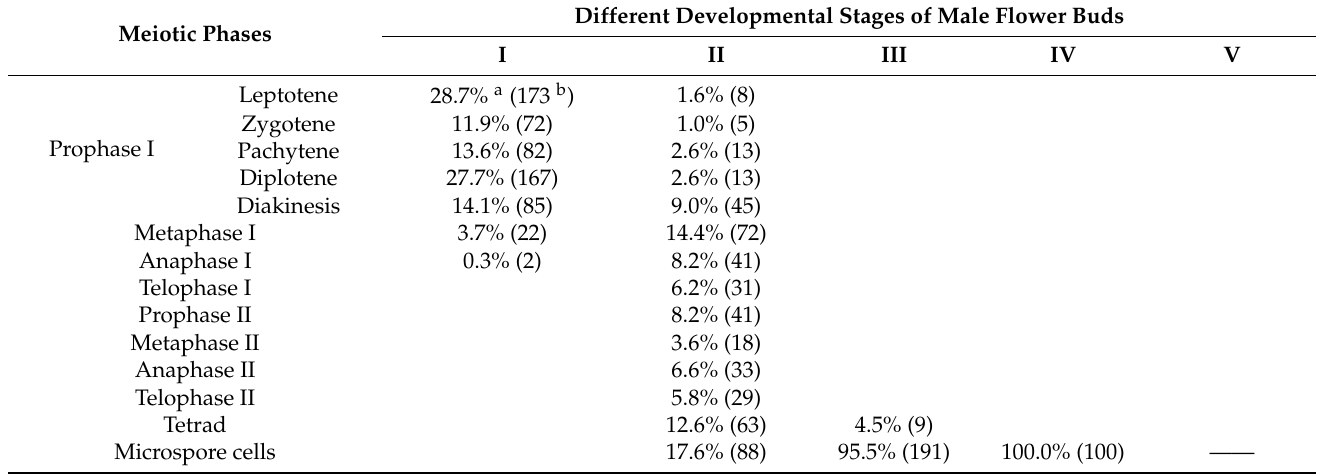
Table 1. Meiotic process at different developmental stages of male flower buds of ‘Shixia’ longan.